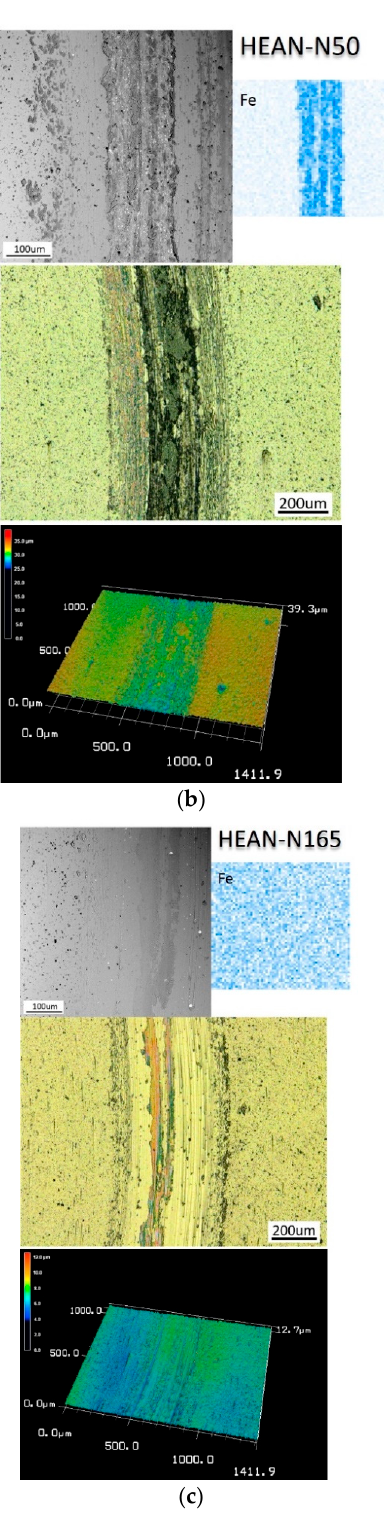
Figure 7. ( a ) 3D optical profilometry images (bottom), SEM images (middle) and EDS Fe element mapping (top) of the wear track of the HEA coated high speed steel samples; ( b ) 3D optical profilometry images (bottom), SEM images (middle) and EDS Fe element mapping (top) of the wear track of the HEAN-N50 coated high speed steel samples; ( c ) 3D optical profilometry images (bottom), SEM images (middle) and EDS Fe element mapping (top) of the wear track of the HEAN-N165 coated high speed steel